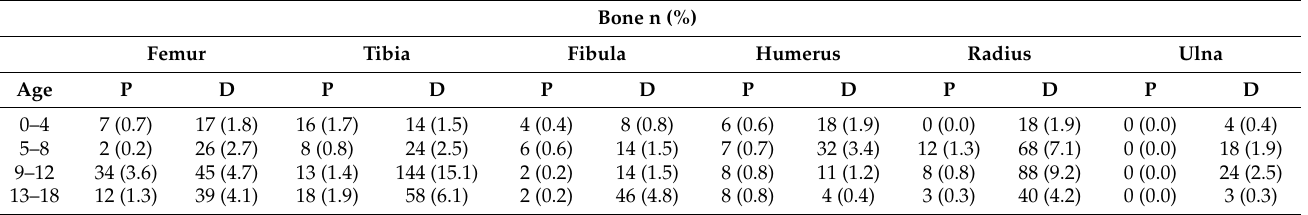
Table 4. Physeal fractures for females according to age, long bone, and location (proximal or distal). N =